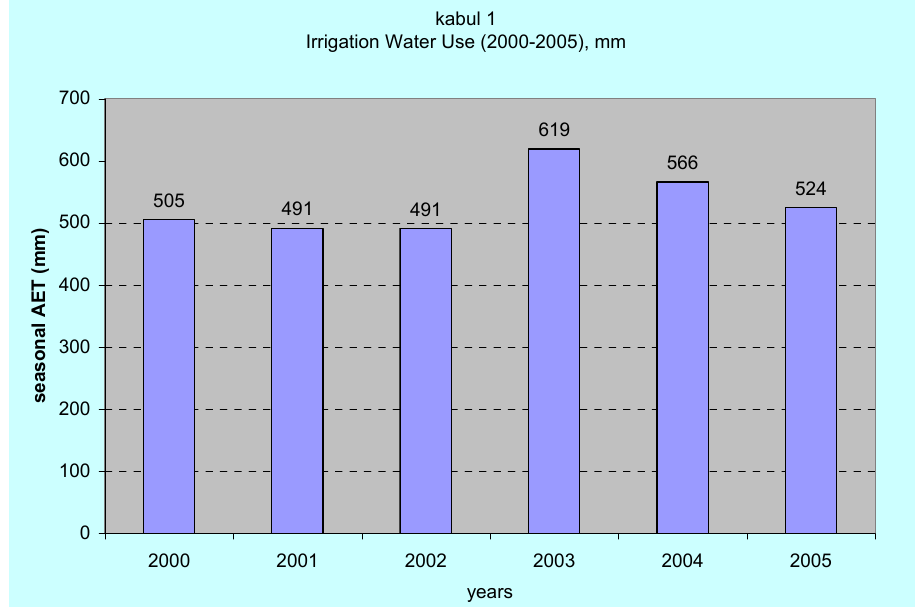
Figure 9. Spatially averaged peak-season (May – Sept.) actual crop ETa (AET) (mm) from 2000-